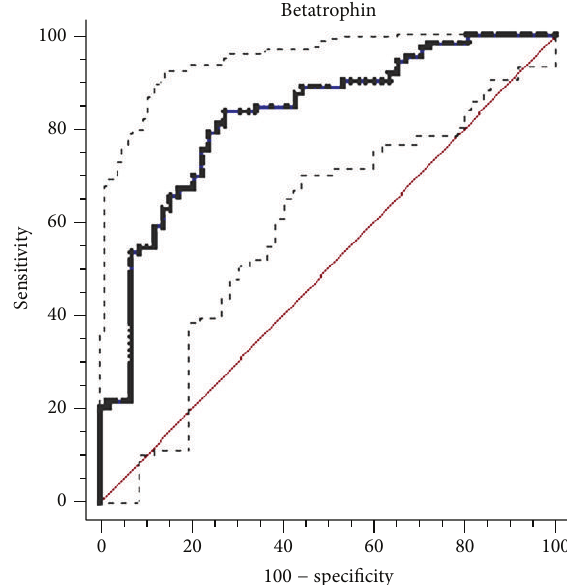
Figure 3: Receiver operating characteristics (ROC) curves showing the performance of betatrophin concentration in detecting type 2 diabetes mellitus. The receiver operating characteristic curve anal- ysis. The optimal cut-off point was 501.23 pg/mL. The area under the ROC curve (area between the solid line and 𝑥 -axis) was 0.824 (95% CI, area between the dashed lines and 𝑥 -axis, 0.748–0.885, 𝑃 < 0.001 ). The sensitivity and specificity are 83.56% and 72.41%,